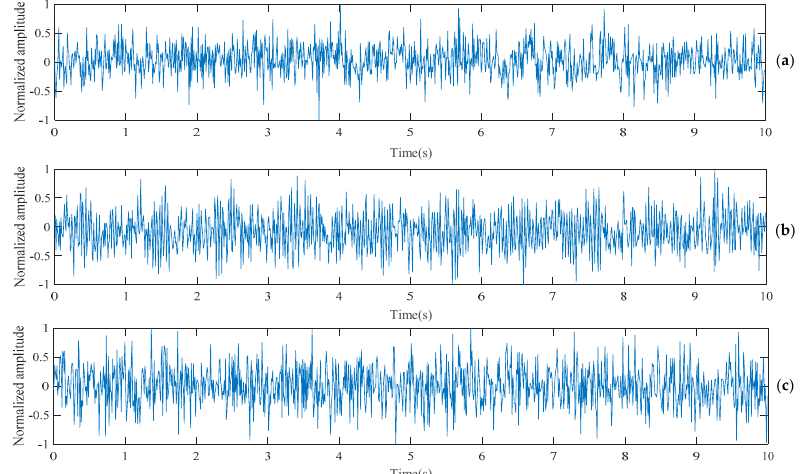
Figure 2. Examples of artificial signals: ( a ) Artificial signal of 5.6 Hz vibration frequency with random noise added; ( b ) Artificial signal of 26.5 Hz vibration frequency with random noise added; ( c ) Artificial signal of 46.8 Hz vibration frequency with random noise added.